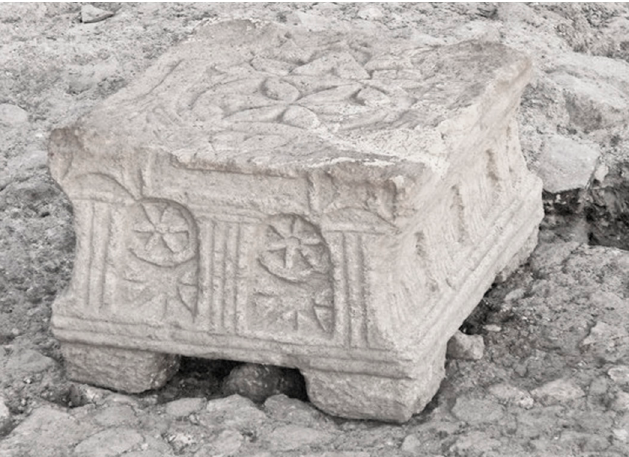
Figure 2. Back Panel, featuring wheels with “flashing fire” beneath. Image used with permission.